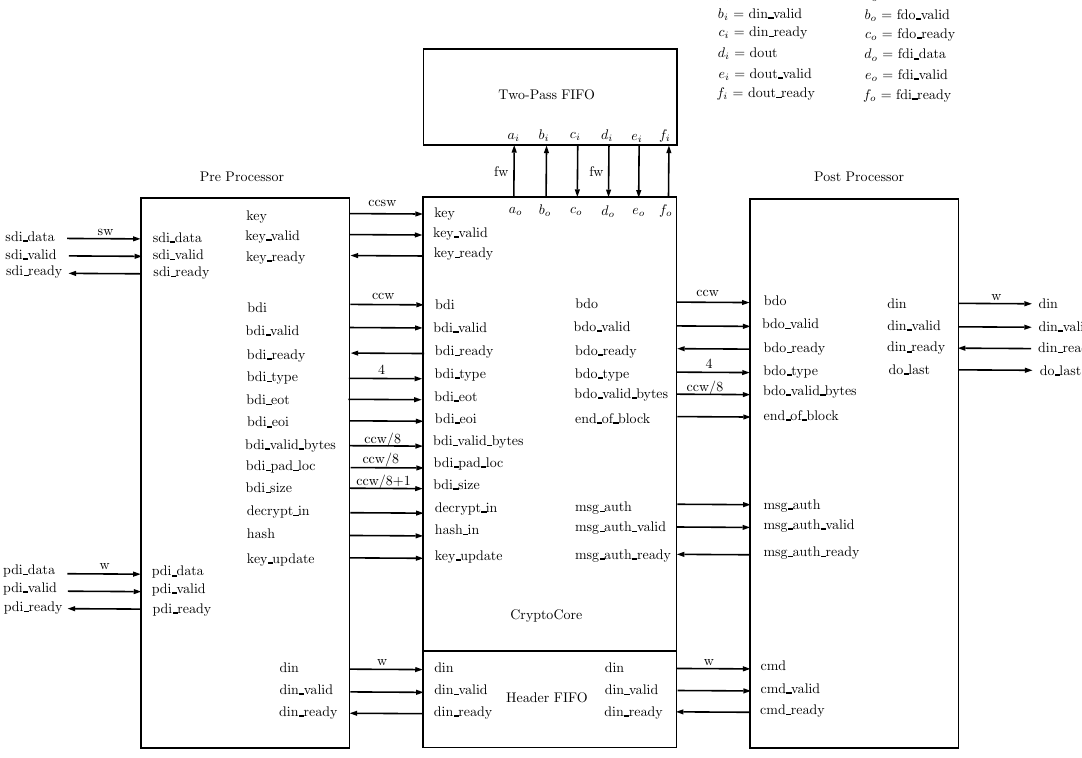
Figure 1. Top-level block diagram of LWC core (based on the scheme found at [9]). sw, external key width; w, external data width; ccsw, internal key width; ccw, internal data width. Table 1. Valid segments in LWC API communication